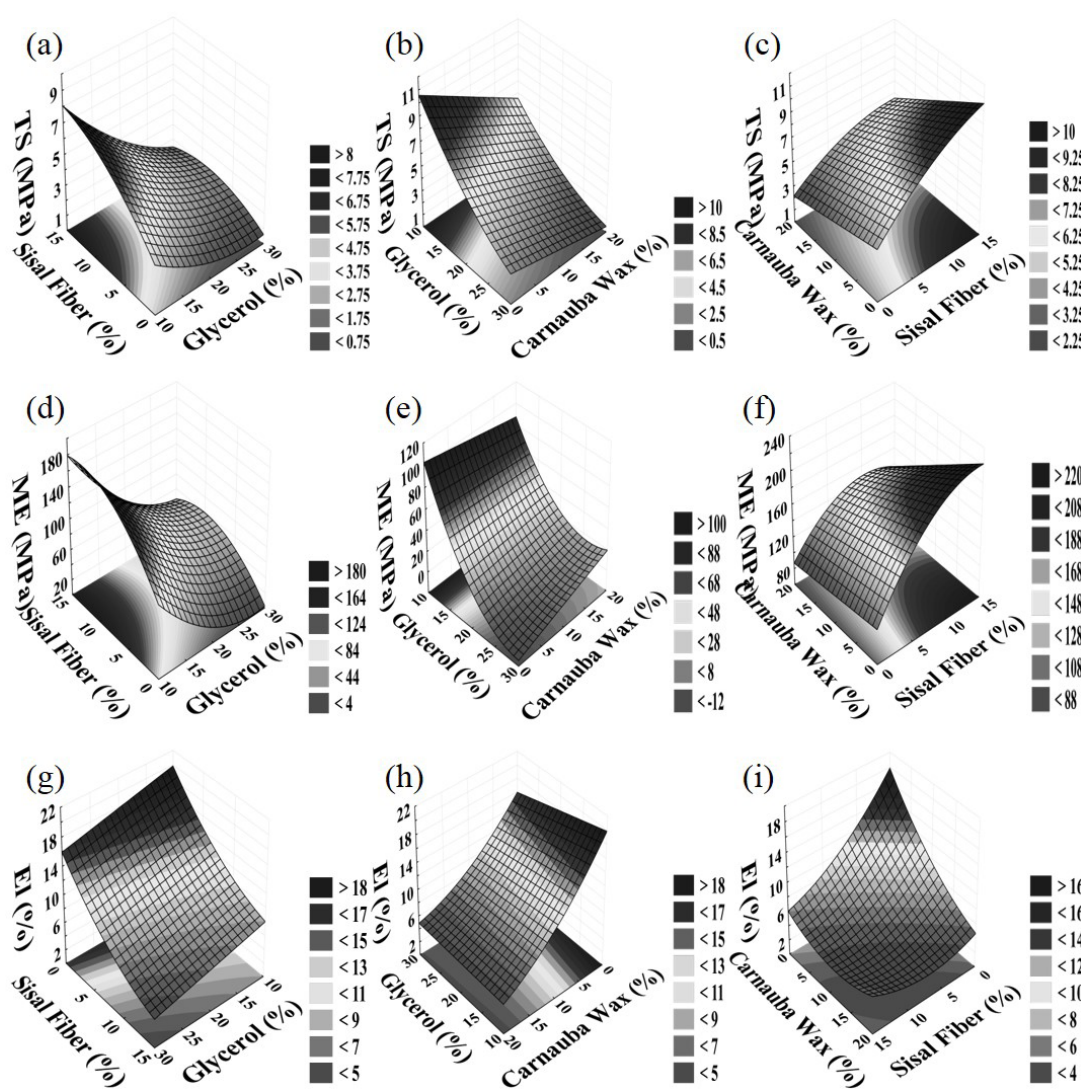
Figure 3. Response surfaces for tensile strength (TS), modulus of elasticity (ME) and elongation at rupture (El) of the biocomposites as a function of: concentration of glycerol and sisal fiber with carnauba wax fixed at (a – 10% CW), (d – 10% CW) and (g – 0% CW); concentration of glycerol and carnauba wax with sisal fiber fixed at (b – 15% SF), (e – 0% SF) and (h – 0% SF); concentration of sisal fiber and carnauba wax with glycerol fixed at (c – 10% G), (f – 10% G) and (i – 20% G).